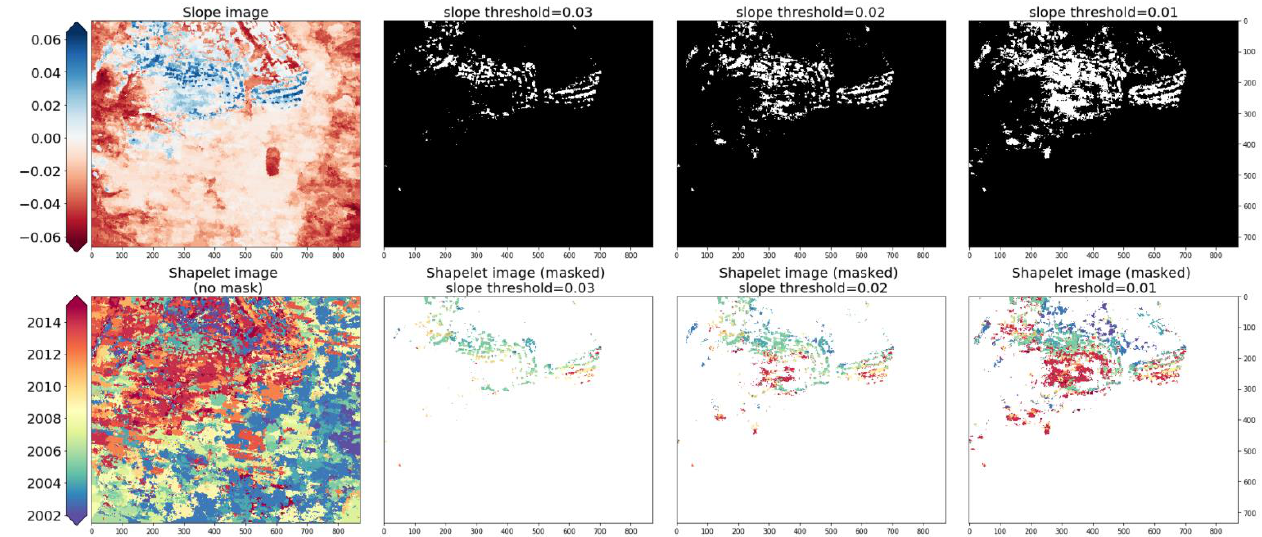
Figure 6. Post BULC-U analysis to identify cropland expansion and the expansion year between 2000 and 2015. The first row illustrates the calculated slope of probability values (column 1) along with the areas of cropland gain identified by using different slope thresholds (columns 2–4). The last row is the shapelet estimated cropland gain year without a mask (column 1) and with a mask applied (columns 2 – 4) using masks from the first row.